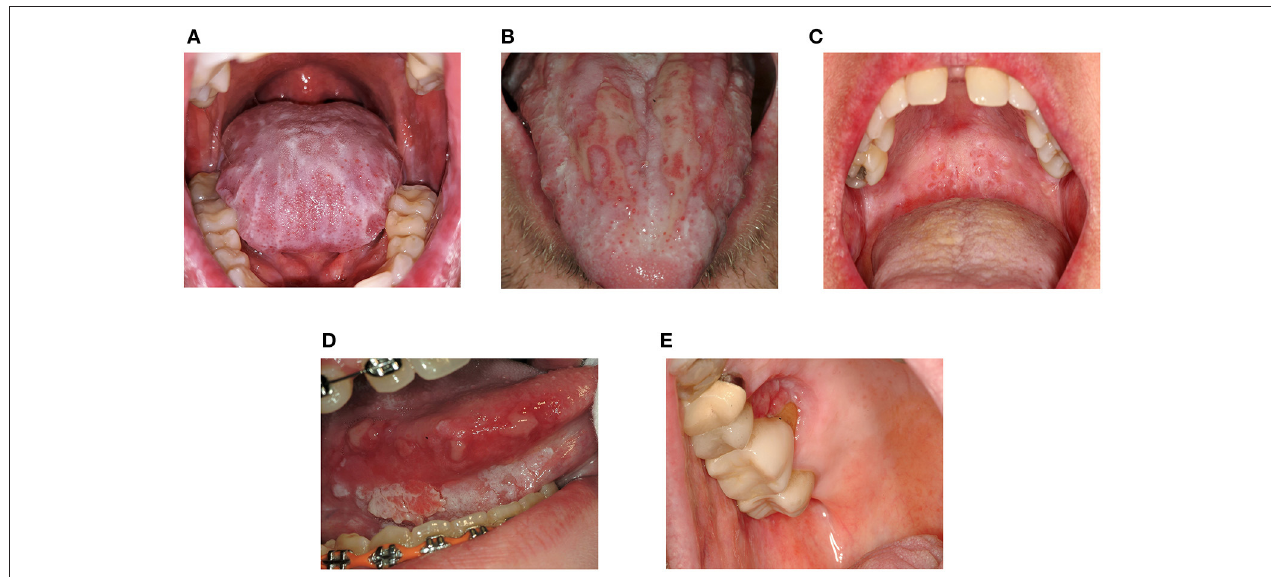
FIGURE 1 | Clinical features of oral mucosal cGVHD and Oral Squamous Cell Carcinoma. (A) Dense lichenoid reticulations involving the dorsal tongue (B) Pseudomembrane-covered ulcerations of the dorsal tongue surrounded by lichen-like changes (lichenoid hyperkeratosis) (C) Superficial mucoceles of the left soft palate. Note the prominent minor salivary glands and thin lichenoid striations affecting the hard and soft palates (D) Squamous cell carcinoma of the right ventrolateral tongue in a patient with longstanding oral cGVHD (E) Squamous cell carcinoma of the right hard palate at a site of persistent cGVHD